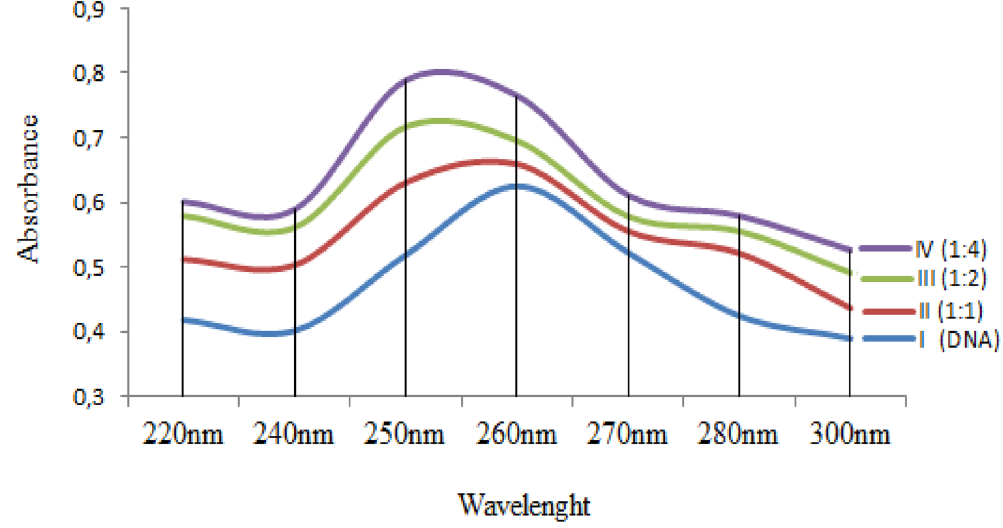
Figure 8. UV absorption spectrum of cypermethrin and DNA